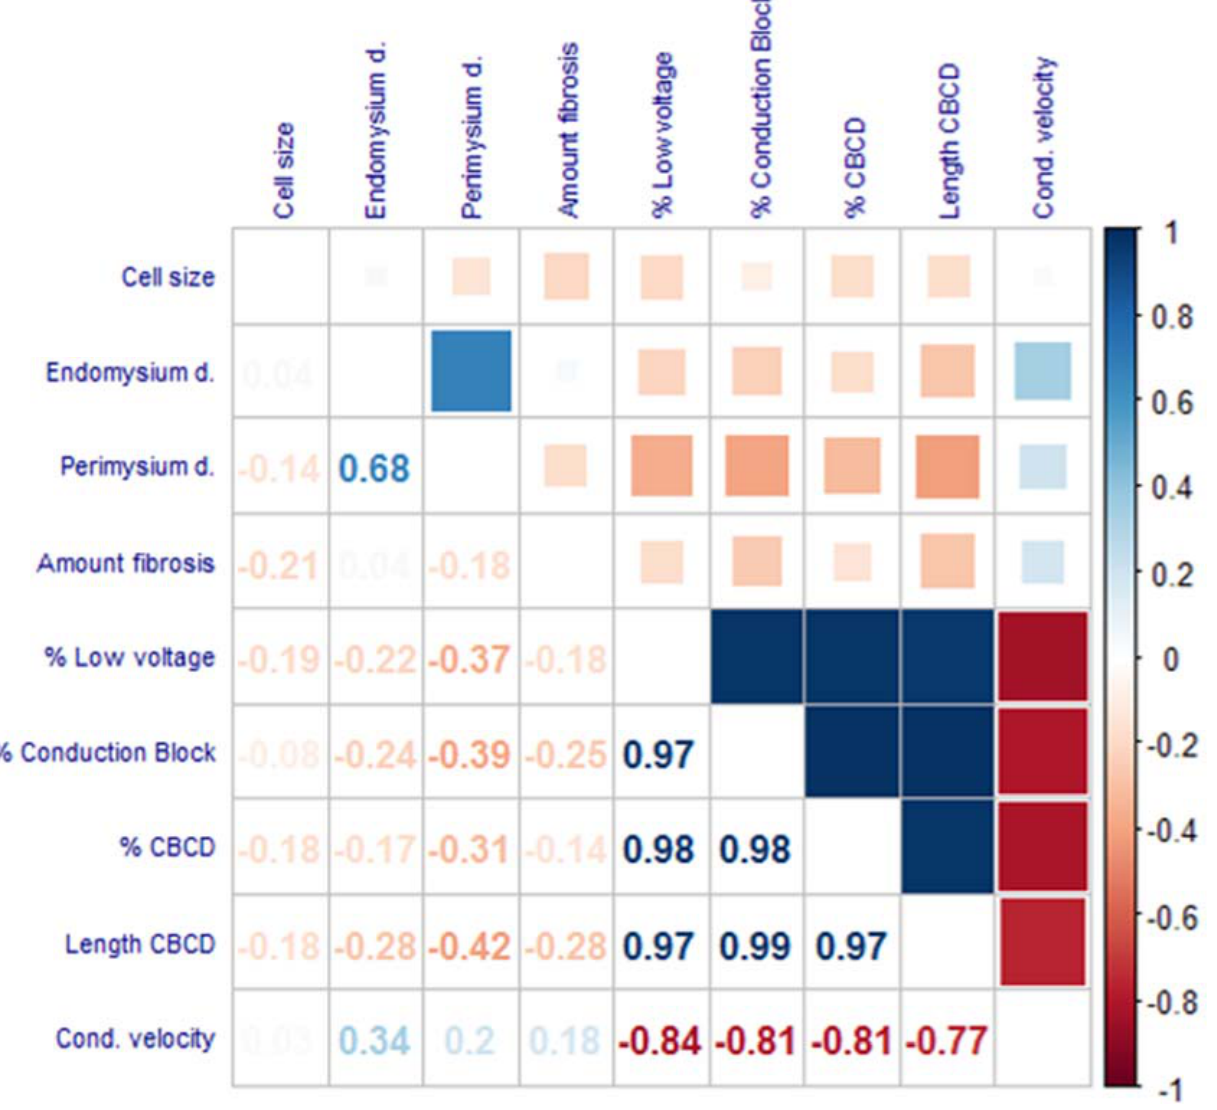
Figure 6. Correlogram with correlation coefficients for histological fibrosis markers and electrophysiological endpoints. No strong correlation ( − 0.8 < R < 0.8) was visualized between histological fibrosis markers and electrophysiological endpoints (N = 35). Statistical tests used: Spearman correlation test.